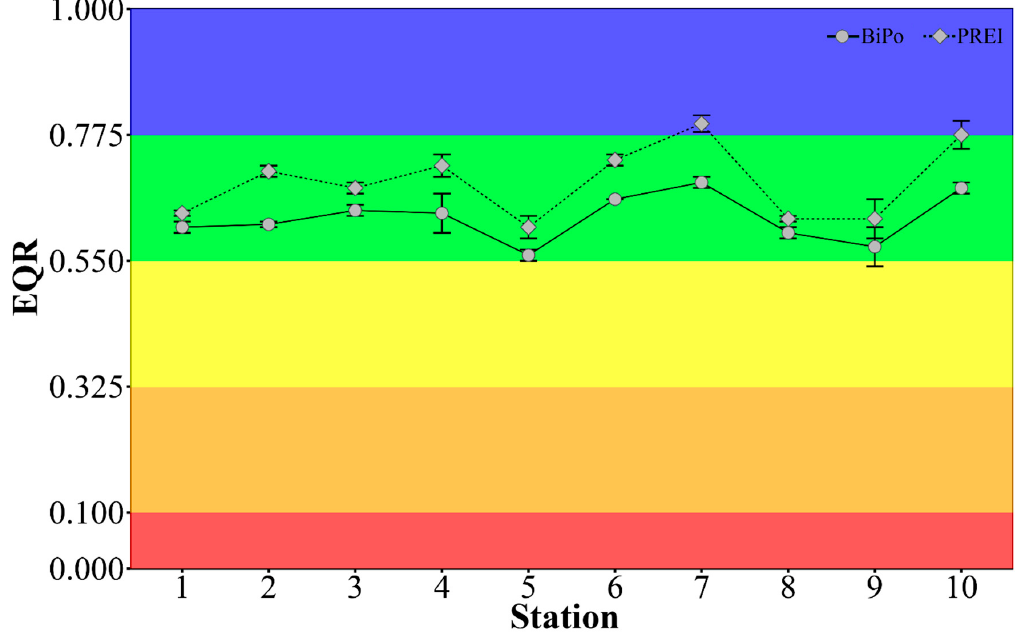
Figure 8. Mean (of two seasons) ecological quality ratio estimated with the PREI and BiPo WFD indices, using the adapted reference conditions, at 10 stations set at about 1 km apart. The error bars represent the SE.